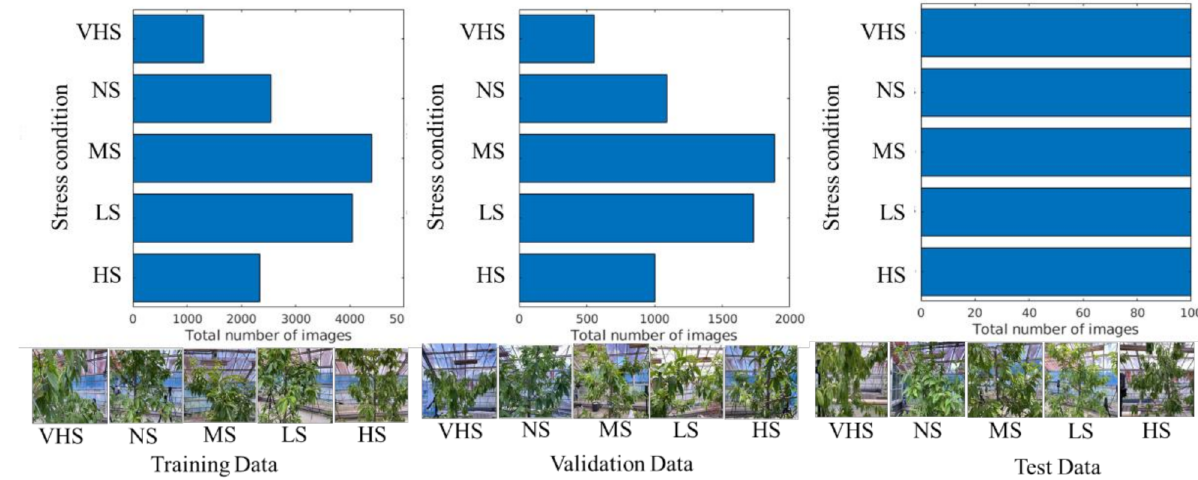
Figure 4. Visualization of the input image dataset.